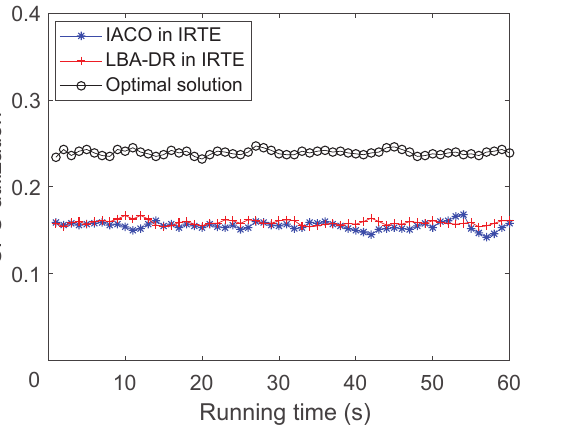
Fig. 6 Increasing flow number in